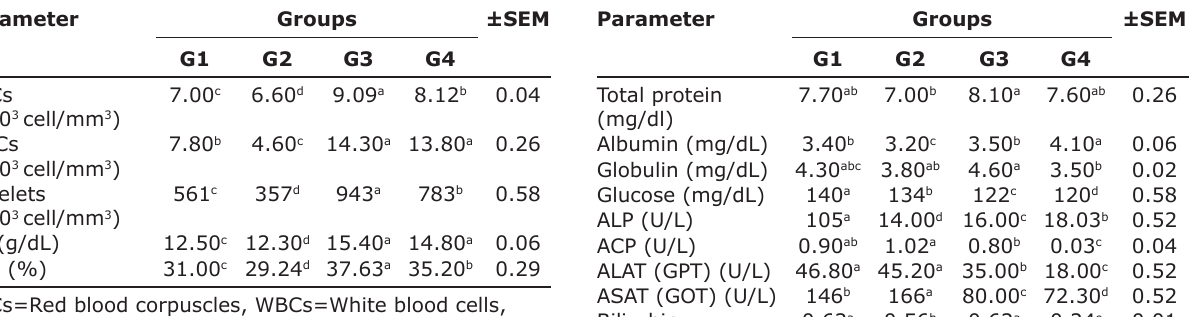
Table-3: Biochemical studies of infected, treated, and control groups. Parameter